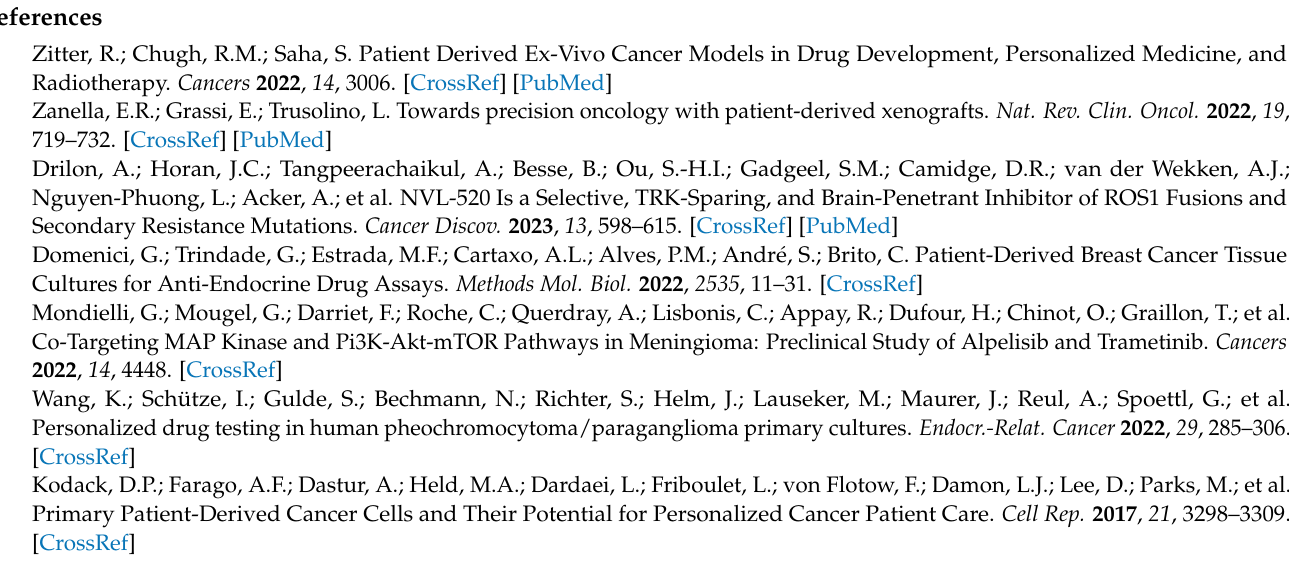
Table S1: FISH probe designs and signal patterns. NA: True amplification can not be assessed with ZytoLight ® SPEC MYC Dual Color Break Apart; Table S2: Further details on percentage of cells with alterations and number of interphase cells counted for each sample passage; Table S3. Further details of the patients and samples included in the study; Table S4. Quality control (QC) parameters of the NGS analyses presented in Table